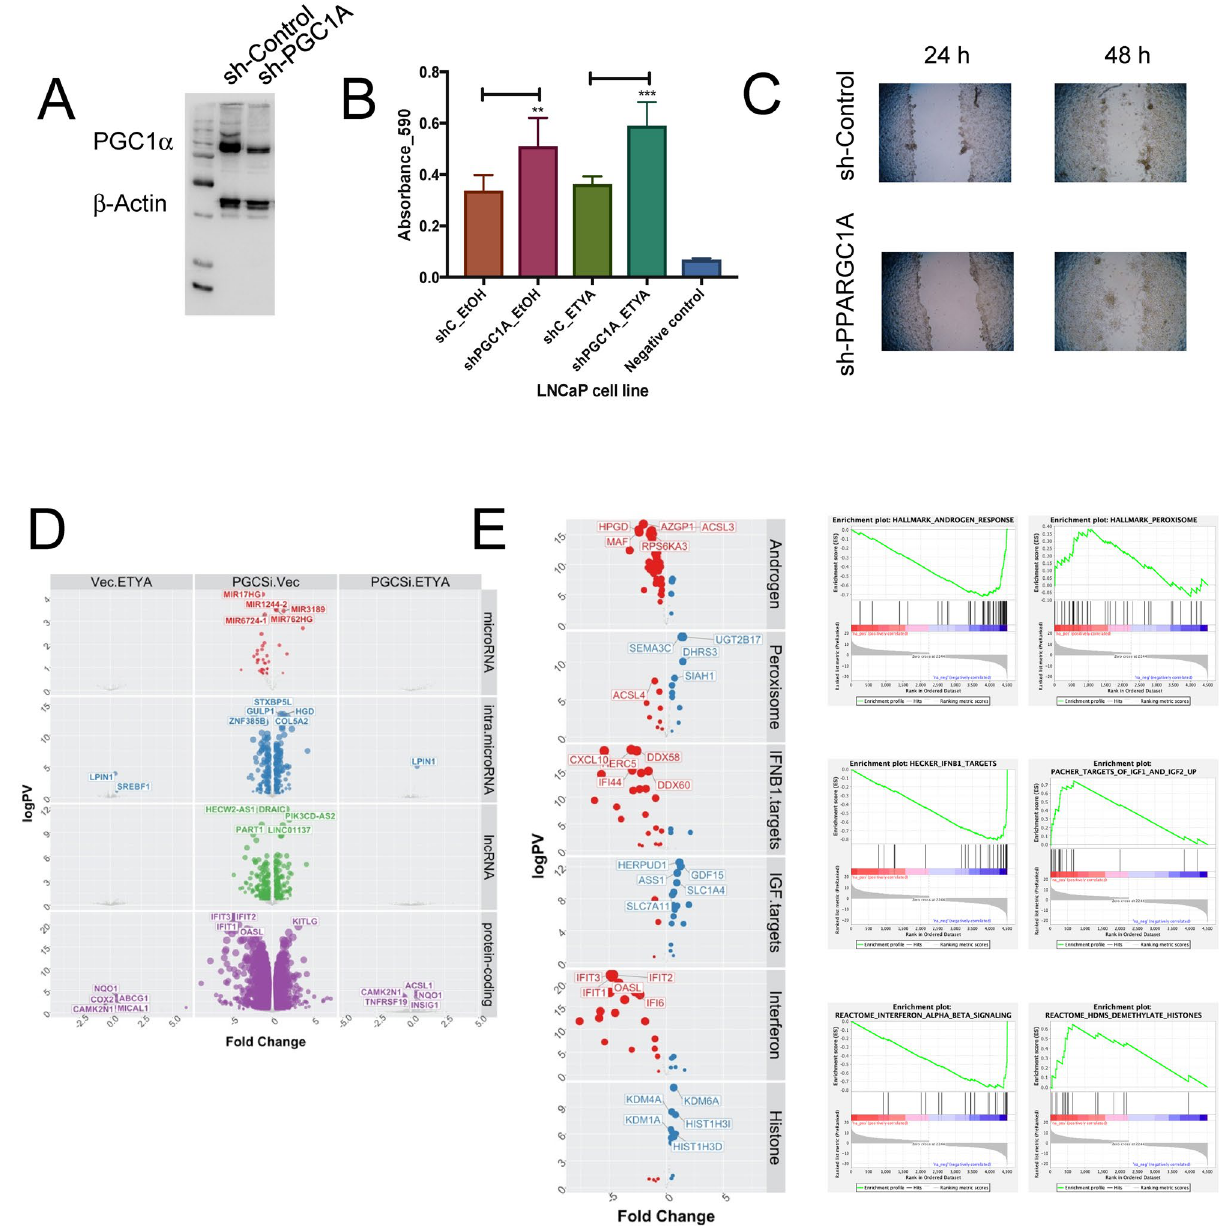
Figure 4. Stable knockdown of PGC1α in LNCaP cells changes proliferation and gene expression patterns. ( A ) LNCaP cells were each stably transfected with two shRNA constructs (sh-PGC1A 34 and 35) targeting PPARGC1A resulting in reduced PGC1α expression (sh-PGC1A) compared to empty vector (sh-CTRL) at protein level as detected in western blotting. ( B ) Measurements of cellular levels of ATP, as an indicator of cell viability was detected in the vector controls and knockdown cells. Each measurement was performed in biological triplicates and in triplicate wells. Cells were treated in triplicate with exogenous PPARγ ligand ETYA (10 µM, 96 hr) or EtOH vehicle control. Increased cell proliferation was seen in sh_PGC1A cells after treatment with ETYA at 96 h. ( C ) Time course scratch closure of sh-Control and sh-PPARGC1A cells mechanically wounded with p200 sterile pipette tip, sh-PPARGC1A after 48 h showed increased cell migration compared to sh-Control. ( D ) LNCaP sh-PGC1A and sh-CTRL cells were treated with ETYA (10 µM, 24 h) or EtOH vehicle control and total RNA expression and RNA-Seq undertaken according to the edgeR pipeline. Volcano plots depicting expression changes upon PGC1α knockdown or in response ETYA in the indicated classes of RNA in color (− log10(p.adj) > 1, abs (log2(fold change))). ( E ) Summary of significantly enriched pathways from gene set enrichment analyses (GSEA) (FDR q.val < 0.05) associated with reducing PGC1α expression